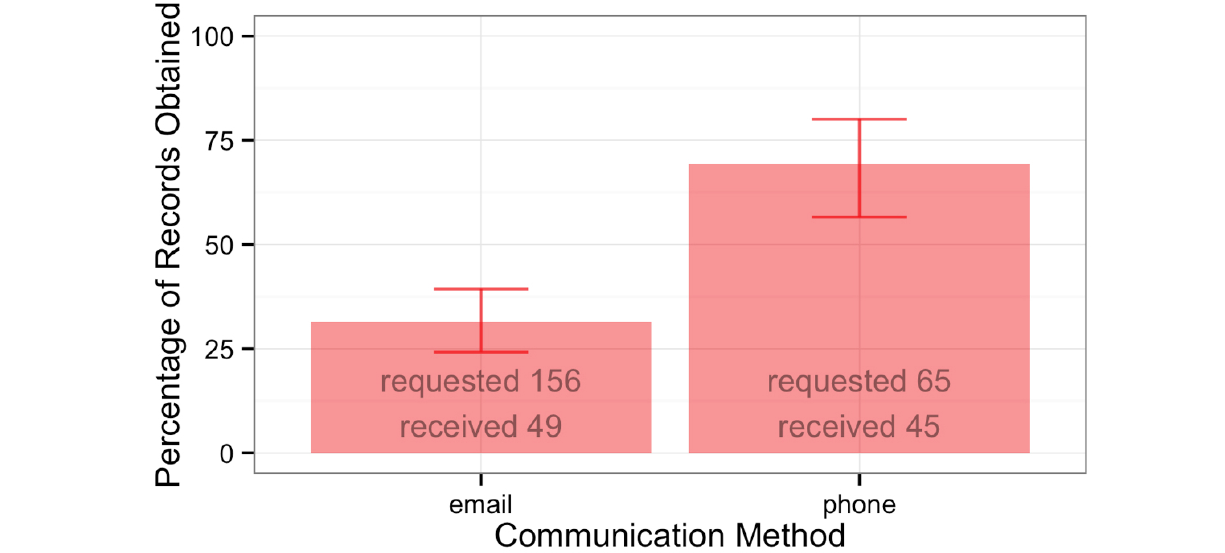
Figure 5. Health records obtained using telephone and